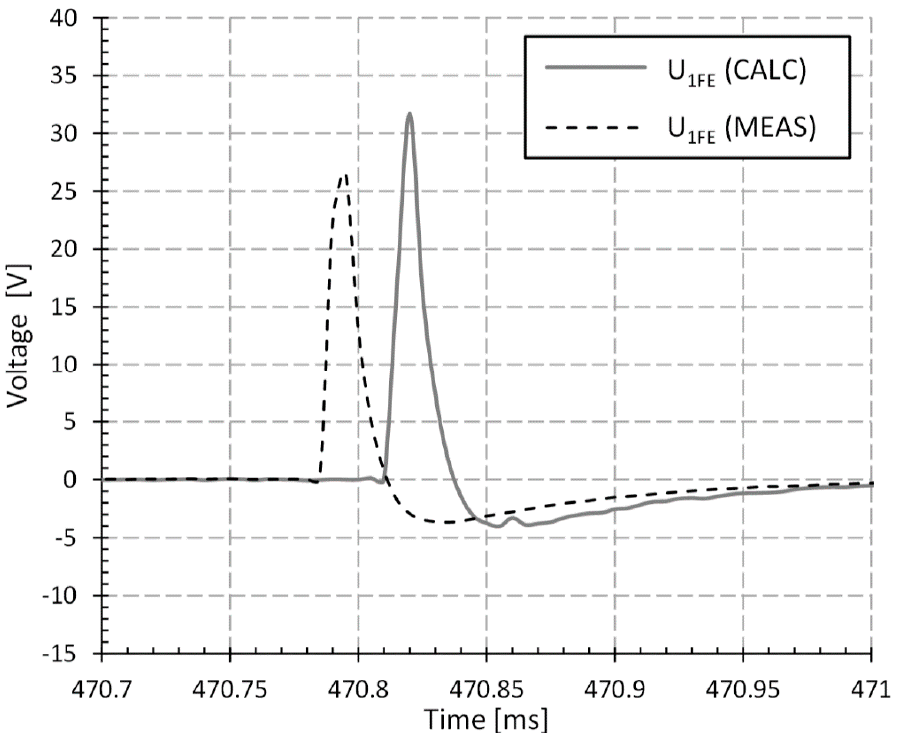
Figure 13. The comparison of measured and calculated voltage of wire 1 at far-end—the view of 18th subsequent stroke.